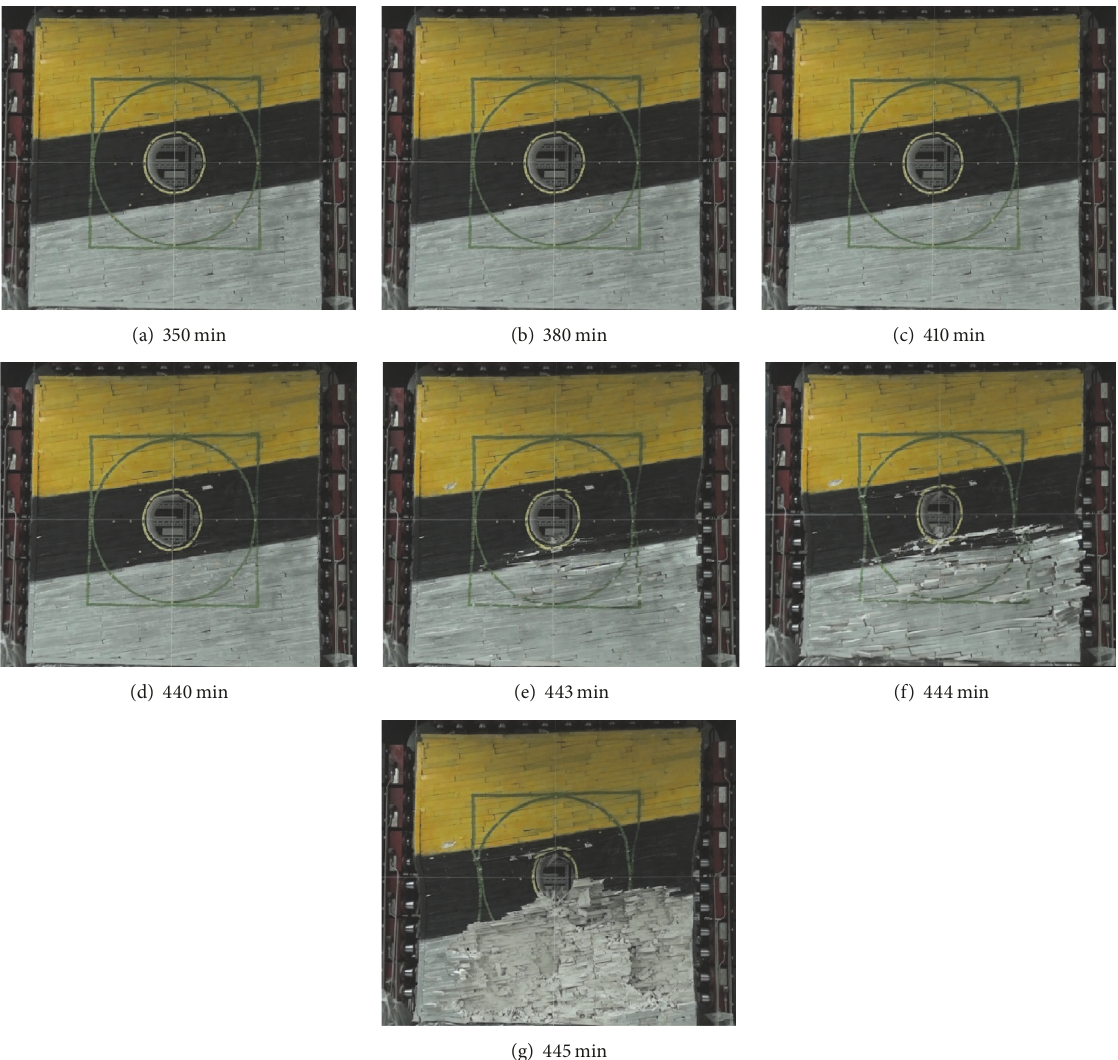
Figure 3: Screenshots of test video according to the loading scheme and phenomenon of deformation; (a)–(d) screenshot of the model in stabilization period after the fifth-seventh loading, respectively; (e)-(f) screenshot of large deformation in lower right area and lower left area which occurred after the eighth loading began, respectively; (g) screenshot of the model when it was